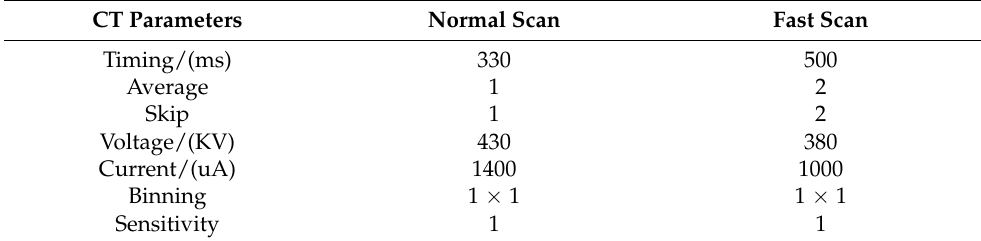
Table 3. CT detection parameter setting